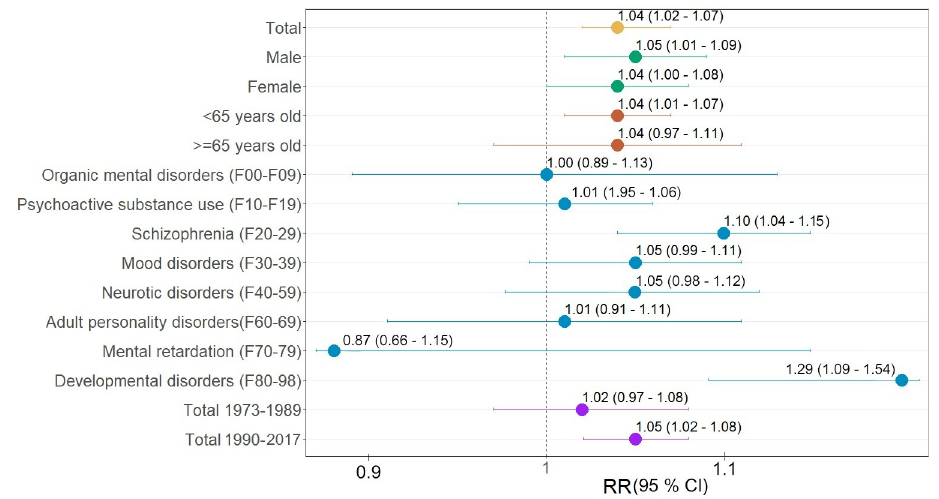
Fig 3. Relative risks (RR, 95% confidence interval (CI)) of mental disorders hospitalizations per 10˚C increase in mean daily temperature (lag 03). Overall result, subgroup analysis by age, sex and subdiagnosis, and temporal analysis. Null hypothesis is that there is no association (RR = 1), thus one can reject the null hypothesis when 95% confidence interval does not include 1.